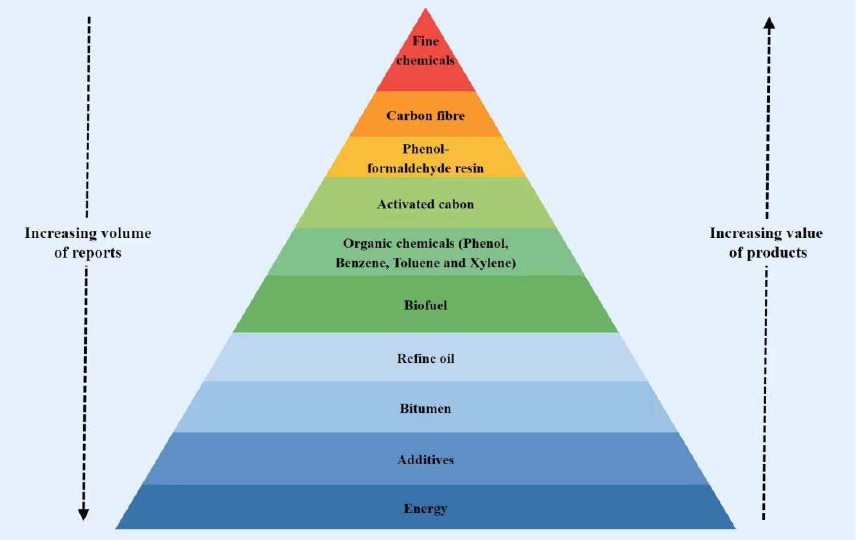
Figure 5. Value-added products manufactured from lignin (adapted from Refs.